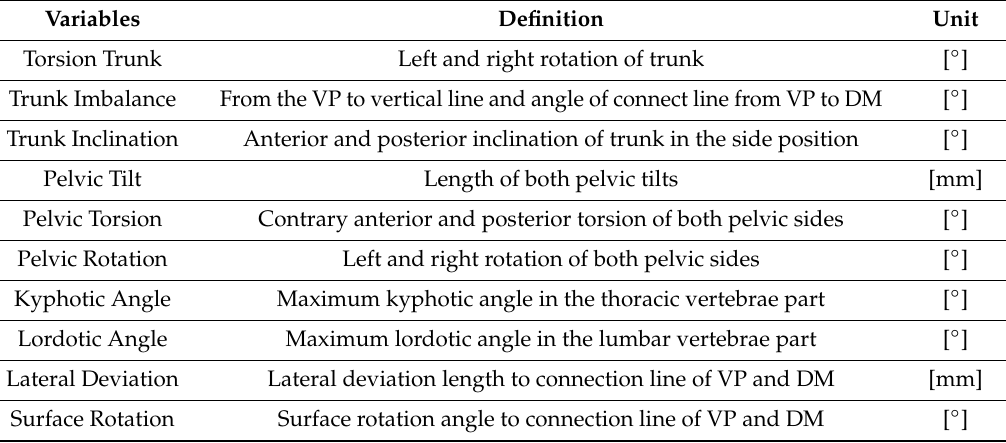
Figure 2. Posture for Formetric III testing and anatomical points (2006). Table 1. Body alignment variables.